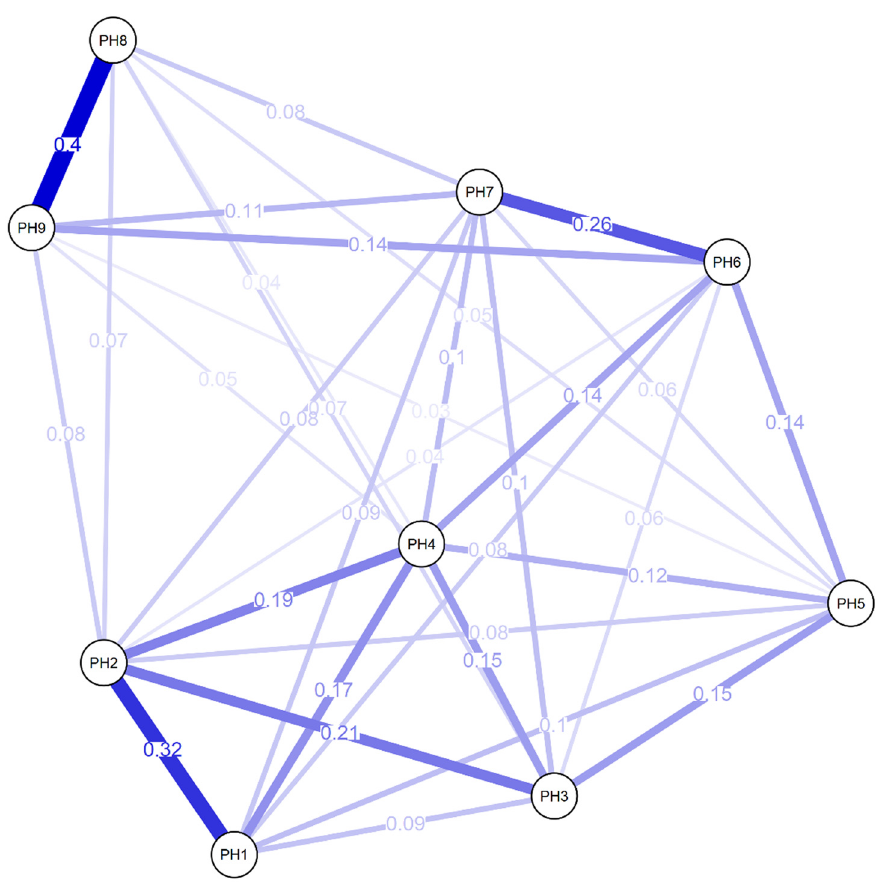
Figure 1. Network analysis of